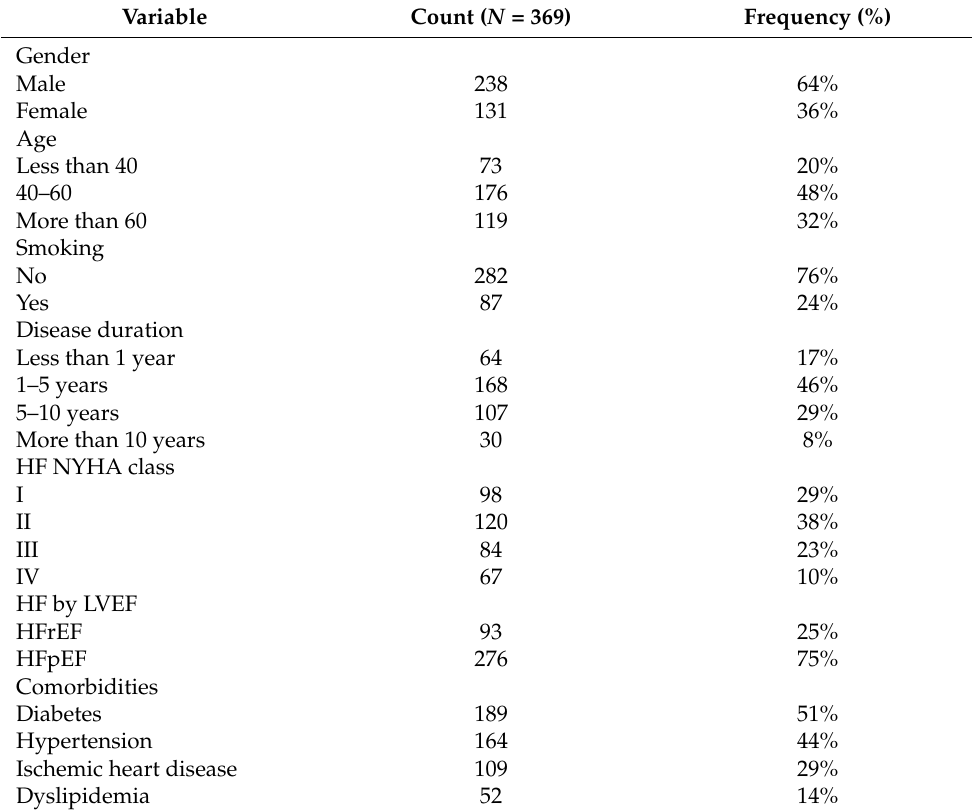
Table 1. Patient’s demographics and disease characteristics.